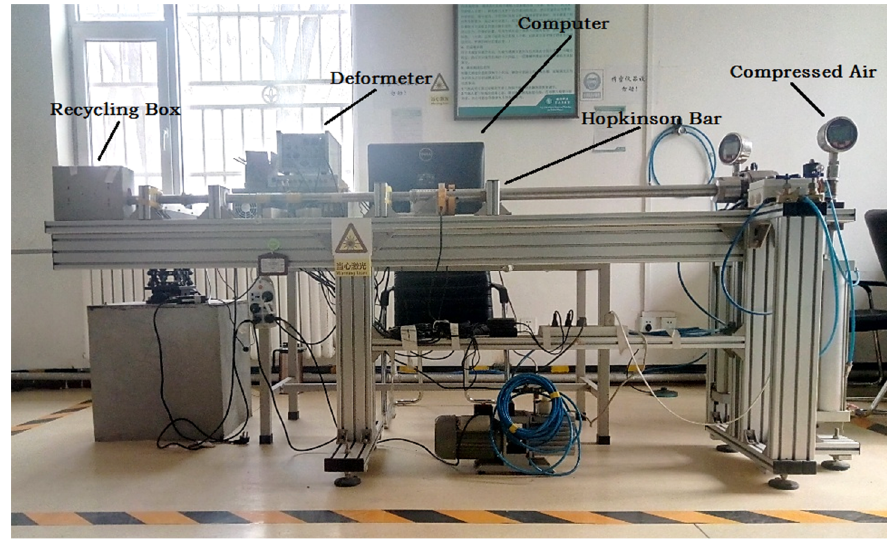
Figure 5. Hopkinson Bar calibration system.